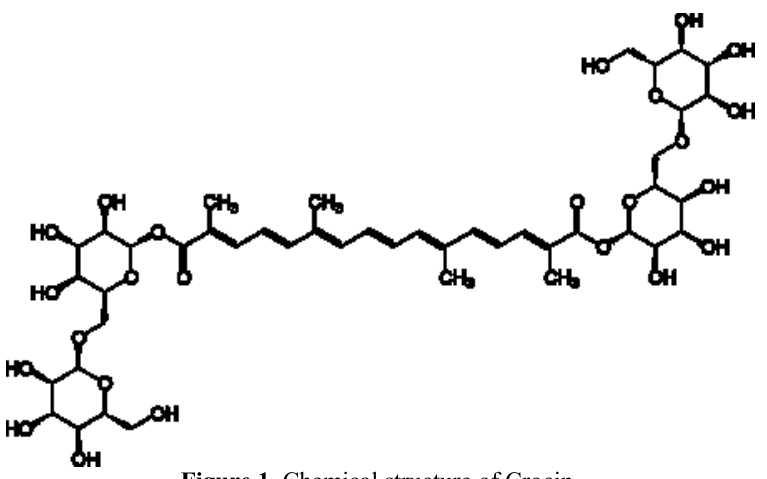
Figure 1. Chemical structure of